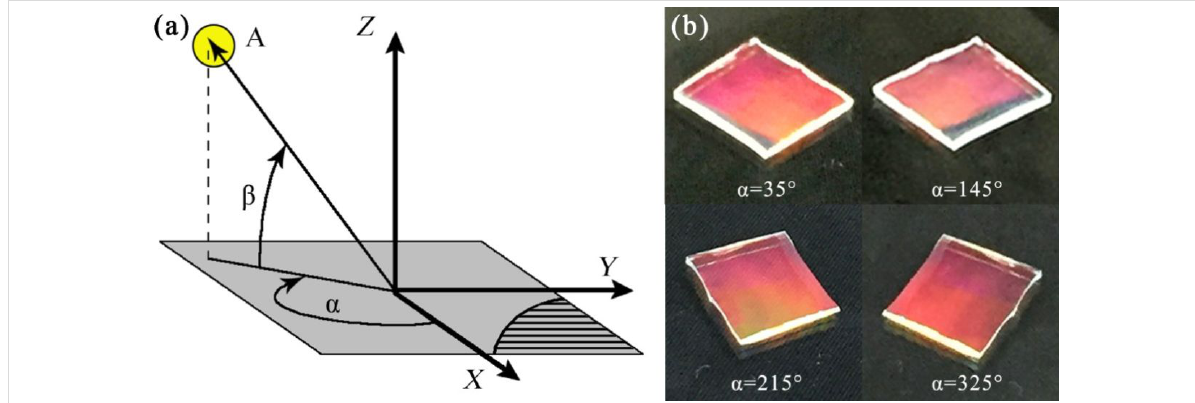
Figure 2: (a) Schematic diagram of the observation angles. (b) Photonic crystal structural color for horizontal observation angles of 35°, 145°, 215° and 325° under a vertical observation angle of 45°.